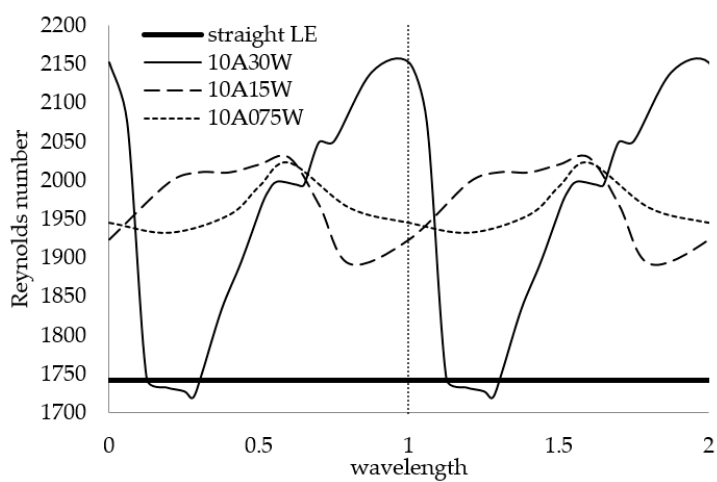
Figure 20. Global critical Reynolds number profile for fixed amplitude and variable wavelength. The wavy leading-edge peak location is shown with the vertical dotted line.